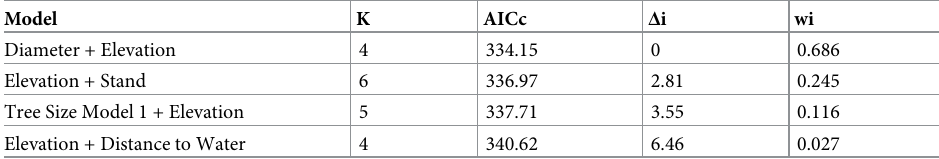
Table 2. Top 4 models for day-roost selection by male and female eastern red bats, along with the number of parameters, AICc score, Δ AICc score, and model weight for each, for Crane Hollow Preserve.